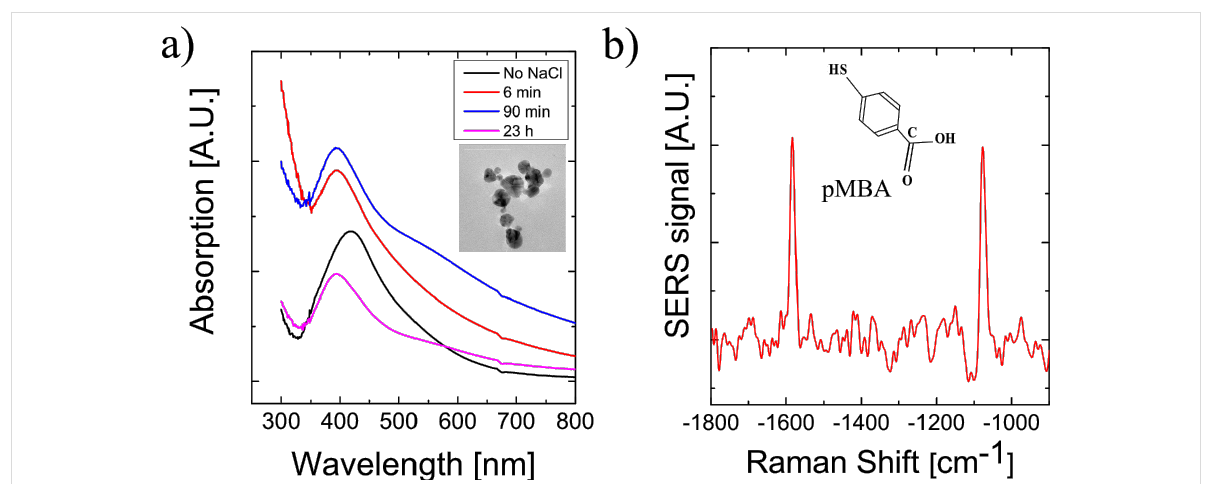
Figure 2: a) Extinction spectra of solutions of green silver nanoparticles made from orange extract before and after the addition of NaCl, final NaCl concentration was 0.2 M. The inset shows an aggregate formed by green nanoparticles. b) SERS spectrum of pMBA collected on green silver nanoparticles as enhancing nanostructure using 50 mW excitation at 785 nm.